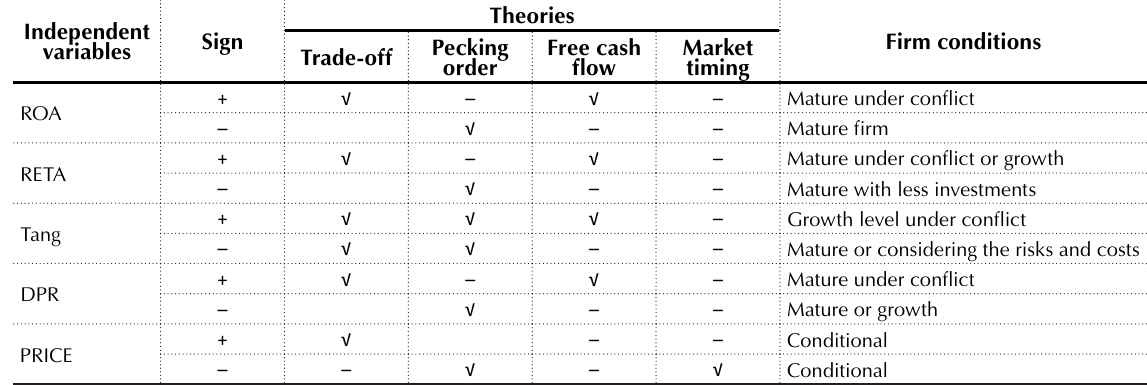
Table 1. Summary of hypotheses development Independent